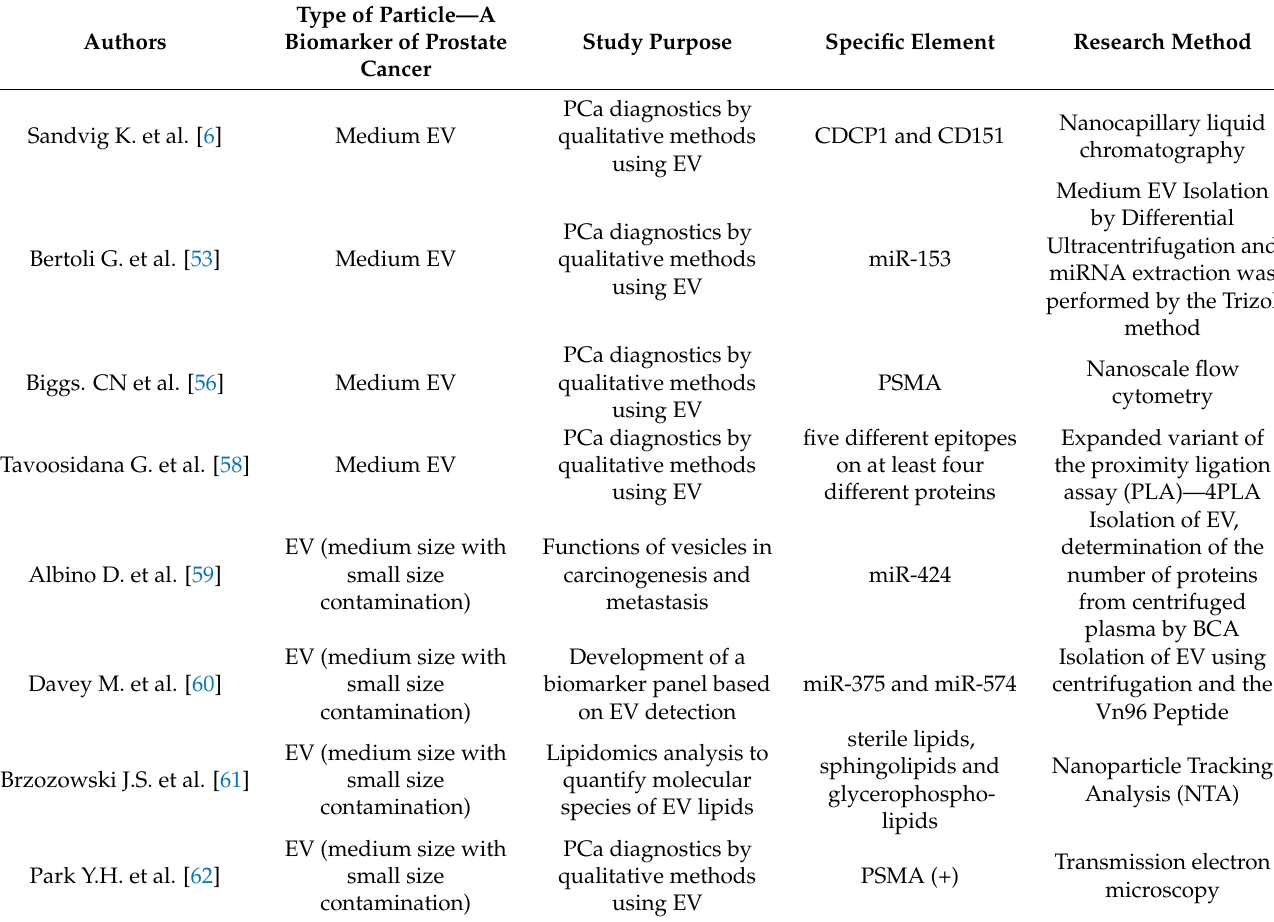
Table 2. List of biomarkers in types of extracellular